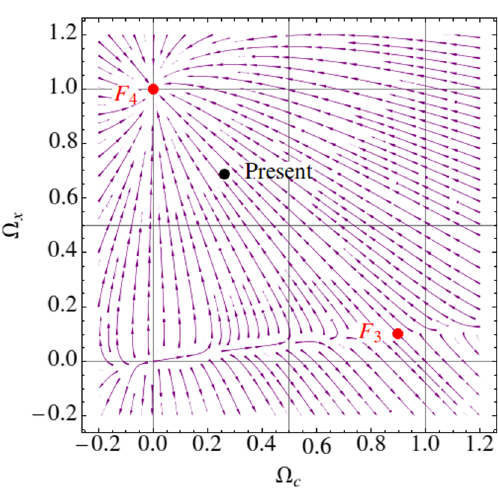
Fig. 6 Projected phase plot for model Γ 2 d with α = 0 .